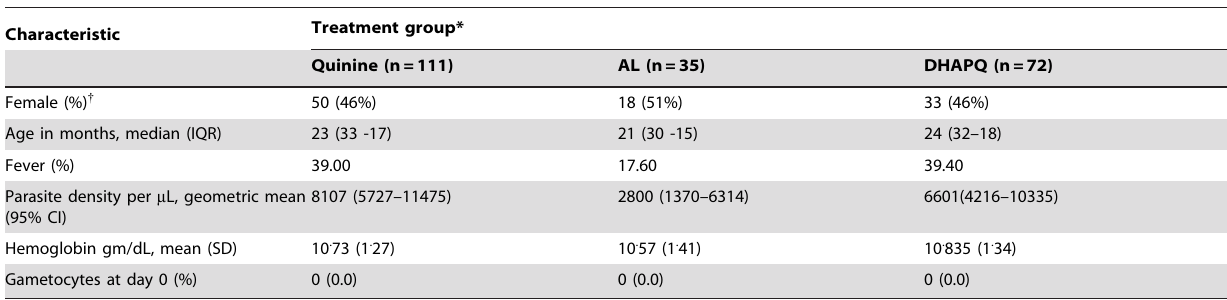
Table 1. Baseline characteristics of patients with efficacy outcomes.